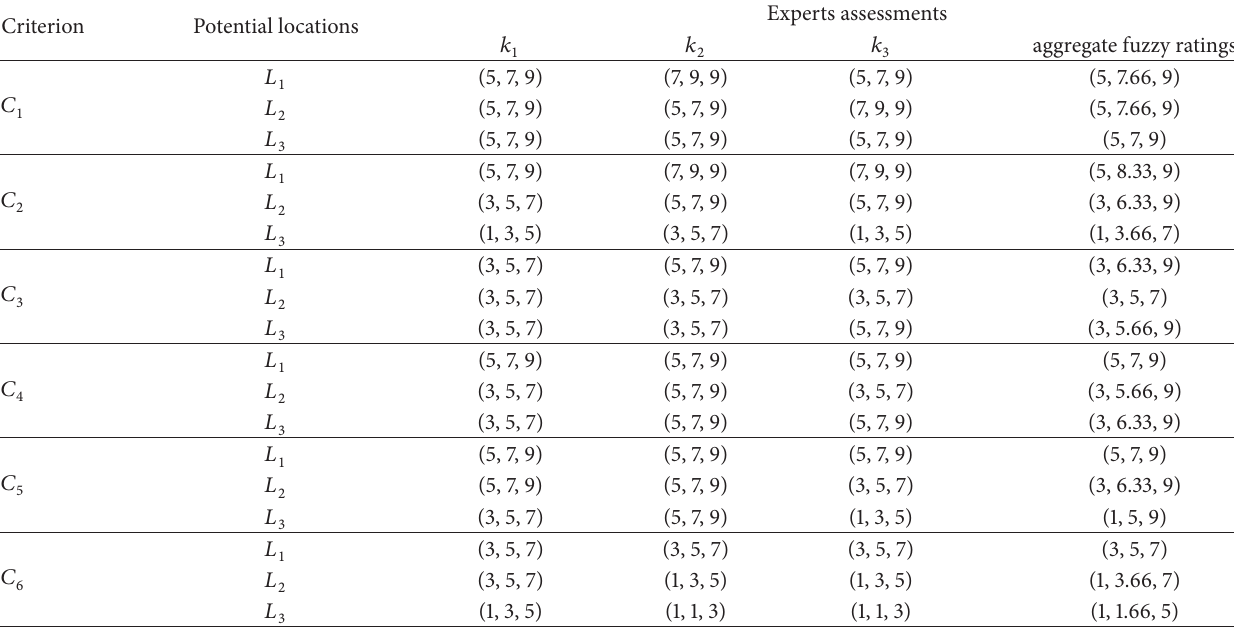
Table 9: The aggregate fuzzy rating of potential locations with respect to each